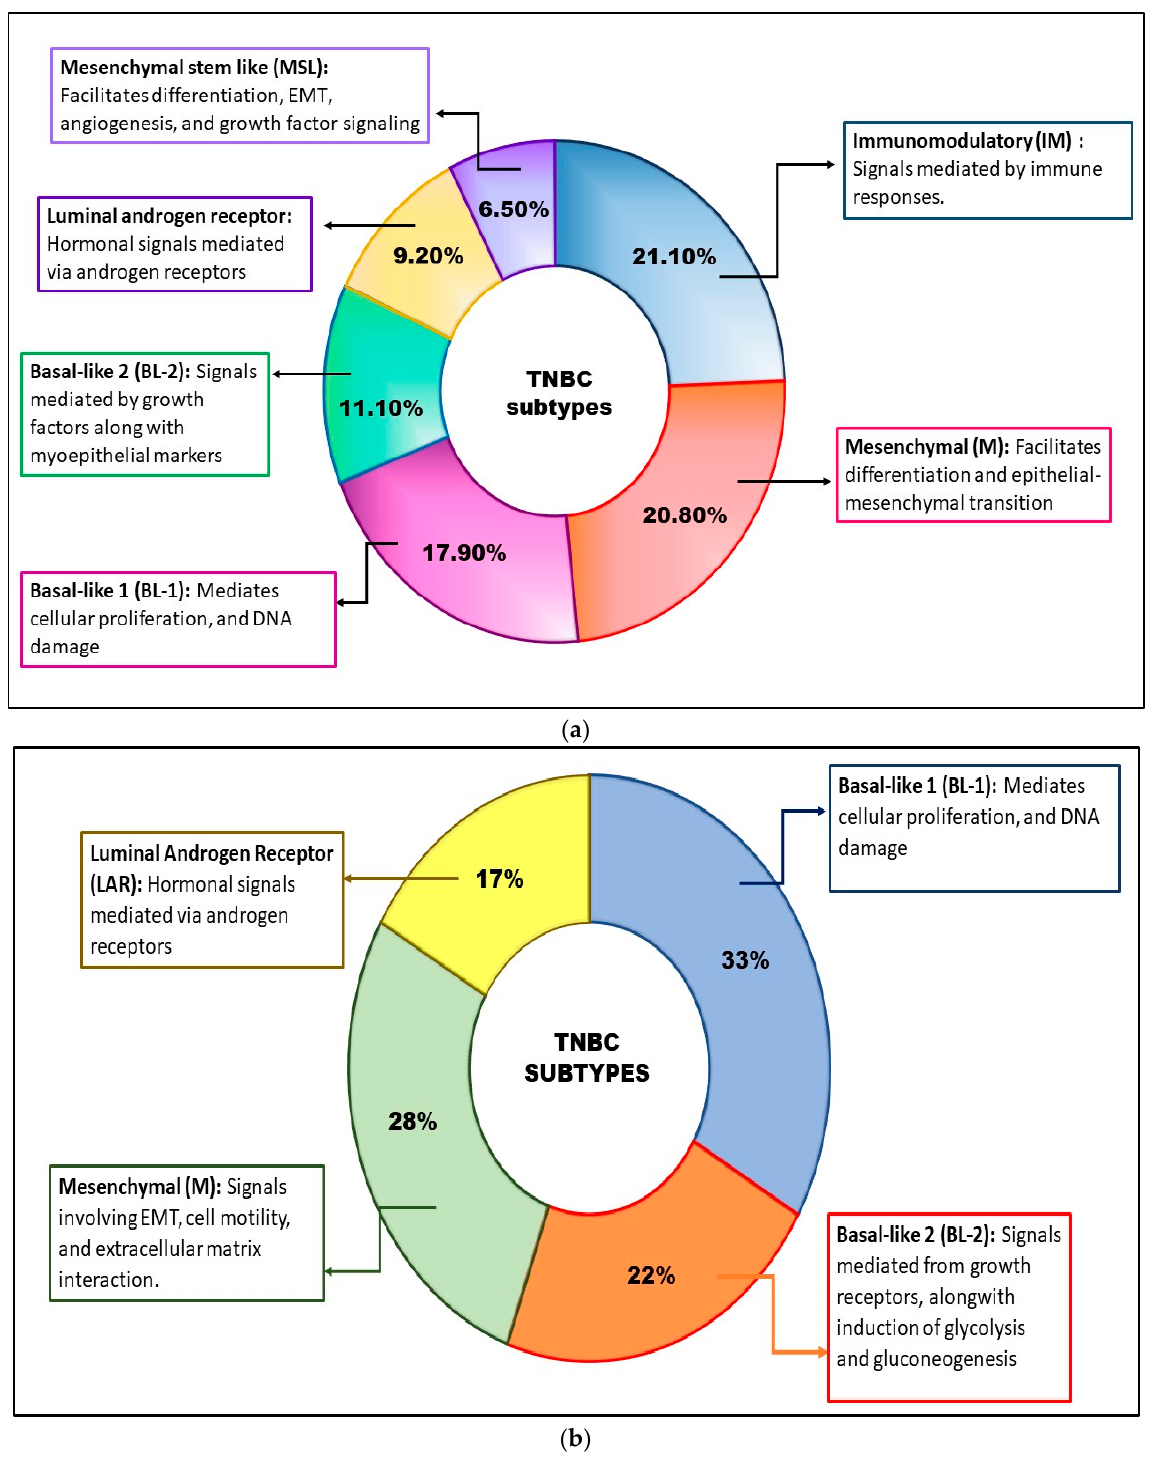
Figure 2. ( a ) Categorization of TNBC by Lehmann et al., 2011: In 2011, Lehmann et al. categorized TNBC into six subtypes based on gene profiling: basal-like 1 (BL-1), basal-like 2 (BL-2), immunomodulatory (IM), mesenchymal (M), mesenchymal stem-like (MSL), and luminal androgen receptor (LAR) [29]. ( b ) Categorization of TNBC by Lehmann et al., 2016: In 2016, on further analysis, Lehmann et al. categorized TNBC into four subtypes: basal-like 1 (BL-1), basal-like 2 (BL-2), mesenchymal (M), and luminal androgen receptor (LAR) [34]. On a similar note, Jiang et al., 2019, scrutinized 465 patients suffering from TNBC at